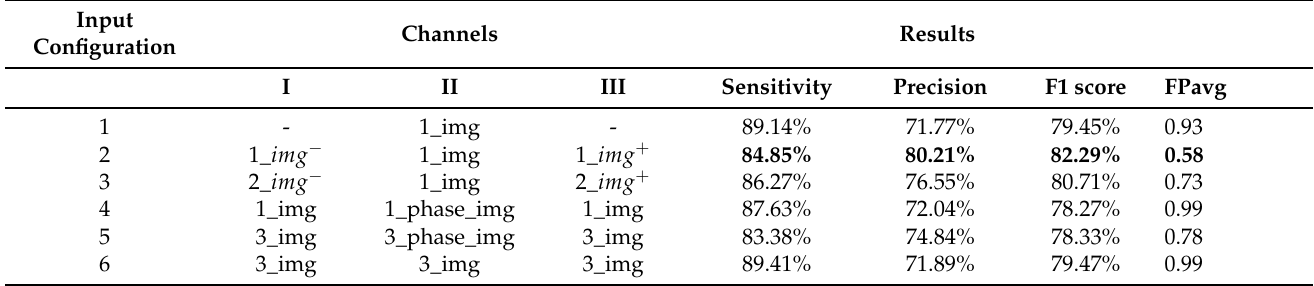
Table 3. Experiment results considering the type of data concatenation. The first three columns present the type of concatenation—which image was put to the channel and the rest are results for each case. Input